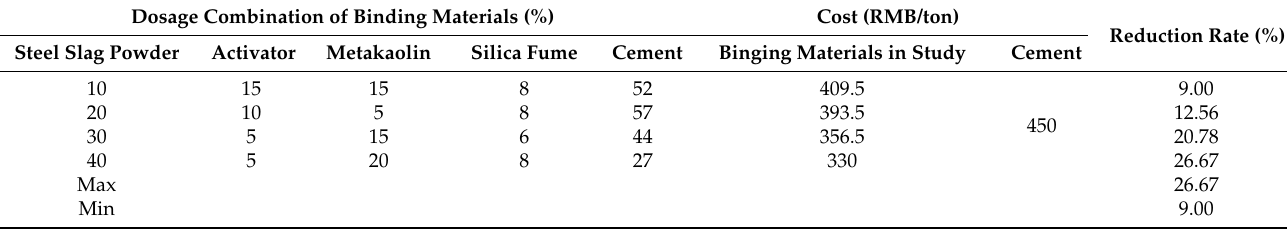
Table 12. Economic benefit analysis on the combination with highest compressive strength in each steel slag powder dosage level. Dosage Combination of Binding Materials (%)